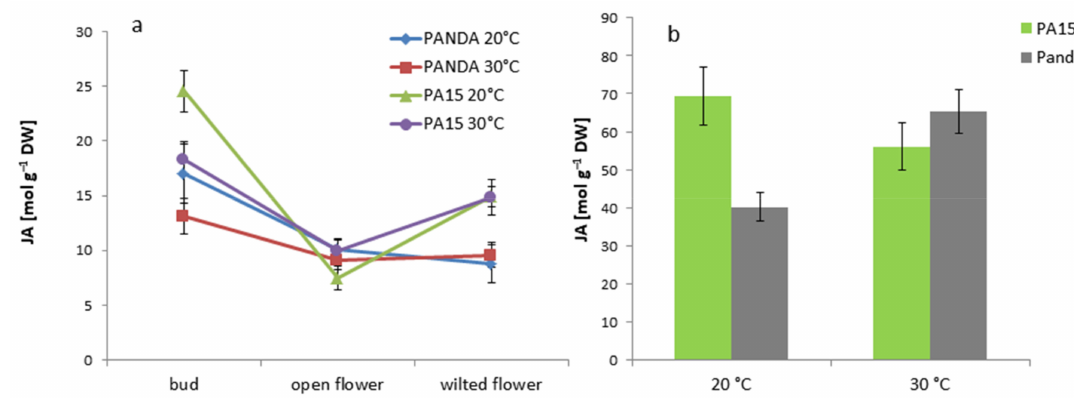
Figure 12. Jasmonic acid (JA) [ µ mol g − 1 DW] in the flower buds, open flowers, and wilted flowers ( a ) and the leaves ( b ) of the ‘Panda’ and PA15 plants grown at 20 ◦ C (control) and 30 ◦ C (thermal stress). Means ( n = 3) ± SE.